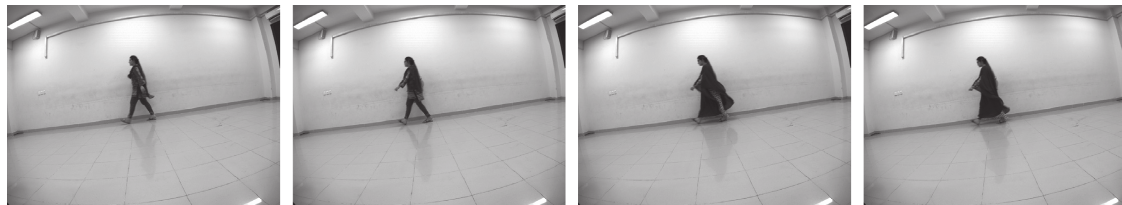
Figure 4: The female subject of the SACV-Gait dataset in different appearances.